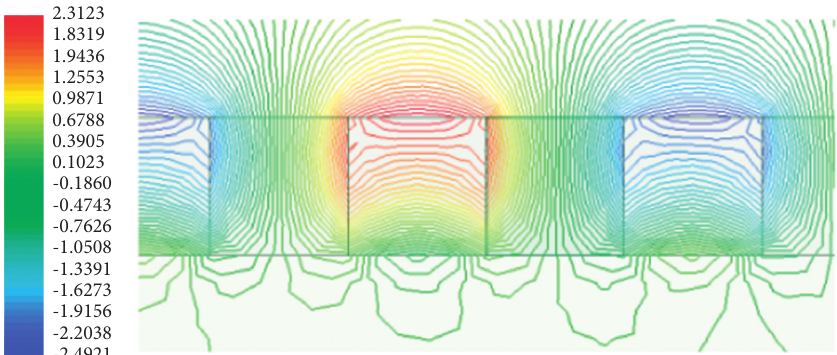
Figure 15: Cloud diagram of finite element analysis of magnetic line of the